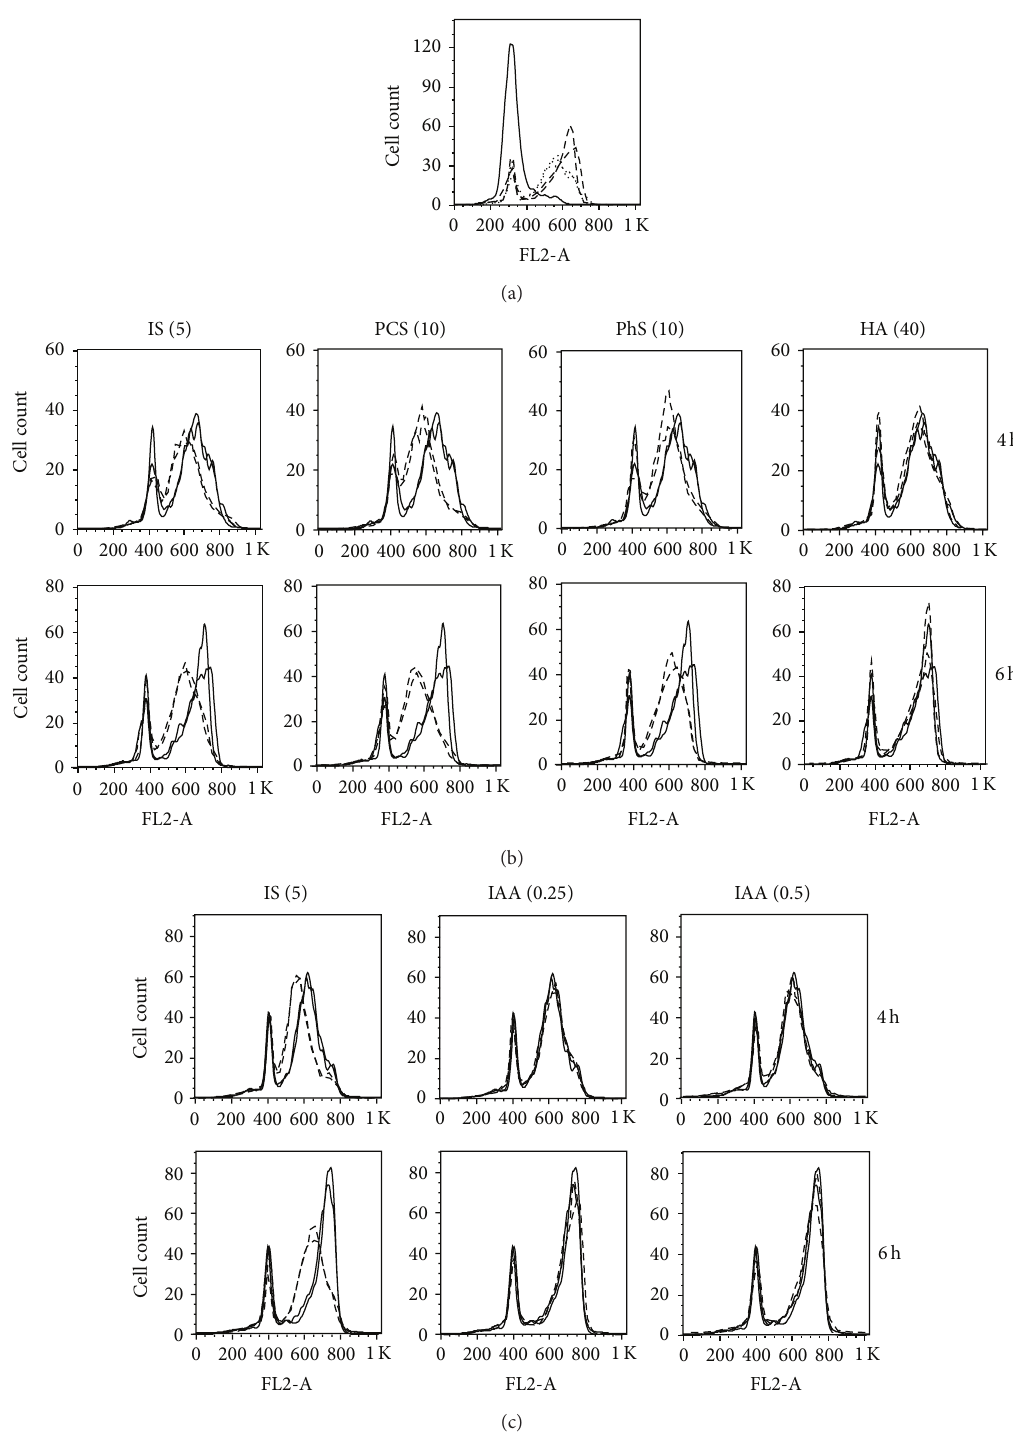
Figure 2: Effects of uremic solutes on cell cycle progression after porcine renal tubular cells were synchronized at G1/S boundary. (a) Time- dependent shift of histograms of untreated control cells. Each line indicates time after release from synchronization. Solid line: 0 hours, dotted line: 4 hours, and dashed line: 6 hours. Duplicate data for each time point are shown except for 0 hours. (b) and (c) Histograms of uremic solute-treated cells and corresponding control cells at indicated time points. After synchronization, cells were released to grow with (dashed line) or without (solid line) uremic solute for indicated periods. Cont, control; IS, indoxyl sulfate; PCS, p -cresyl sulfate; PhS, phenyl sulfate; HA, hippuric acid; IAA, indoleacetic acid. Concentrations of solutes (mmol/L) are shown in parentheses. Duplicate data are shown. Data are representative of two independent